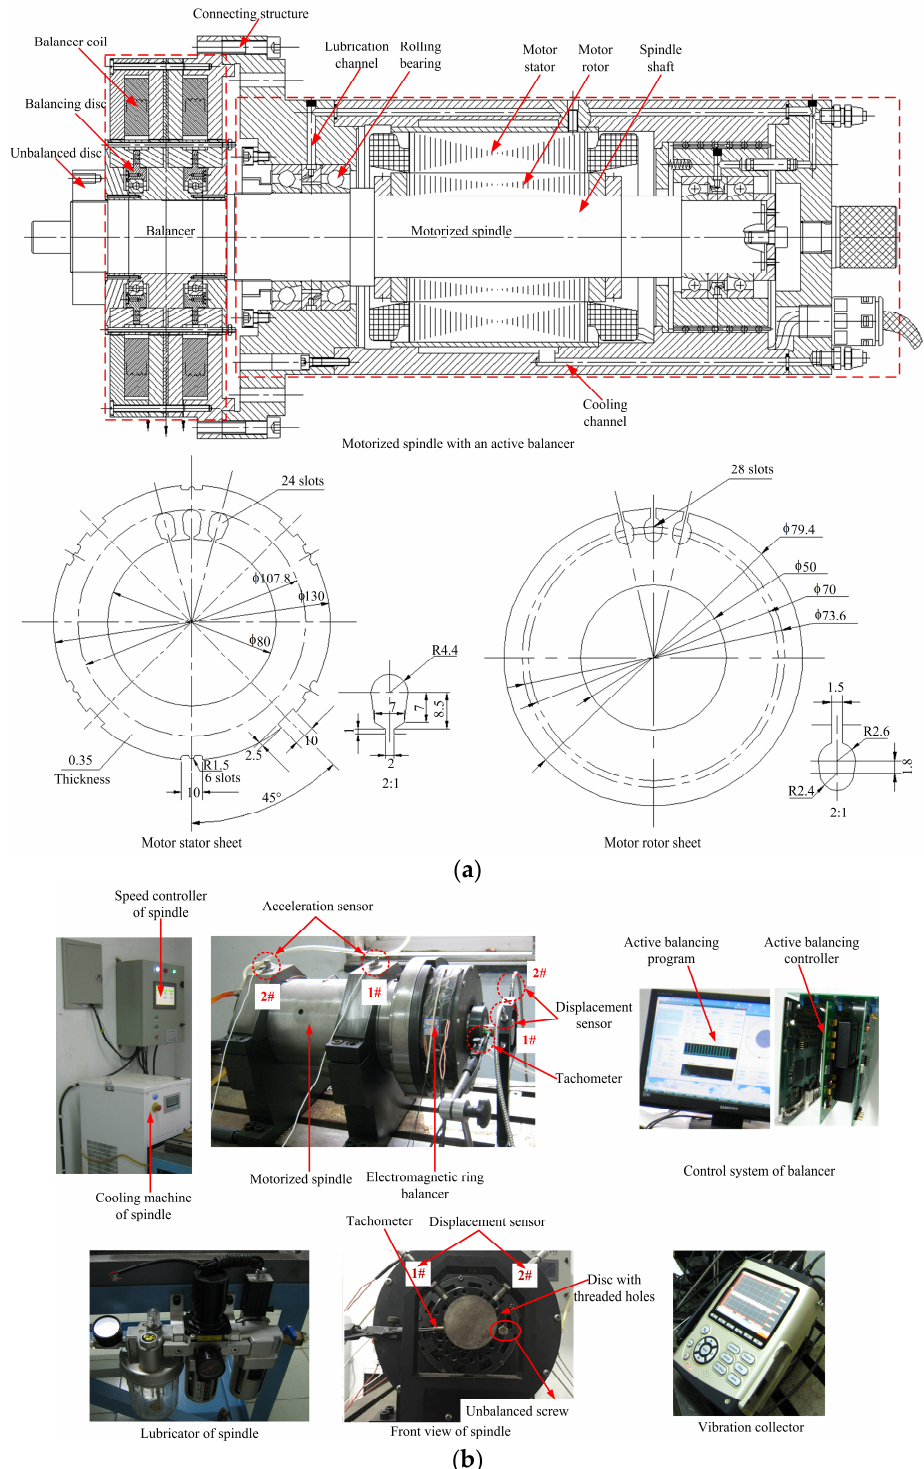
Figure 4. ZYS-170MD12Y16 motorized spindle and its active balancing test system: ( a ) design of a motorized spindle with a balancer and its stator and rotor; ( b ) prototype of motorized spindle with a balancer and its monitoring and control